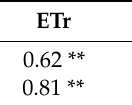
Table 3. Correlation between the precipitation amount, precipitation days, ETr, drought intensity, and drought frequency over the Mun River Basin during the period of 1971 to 2016. Precipitation Amount Precipitation Days ETr − 0.38 ** − 0.58 ** Intensity 0.62 ** − 0.48 ** − 0.42 ** Frequency 0.81